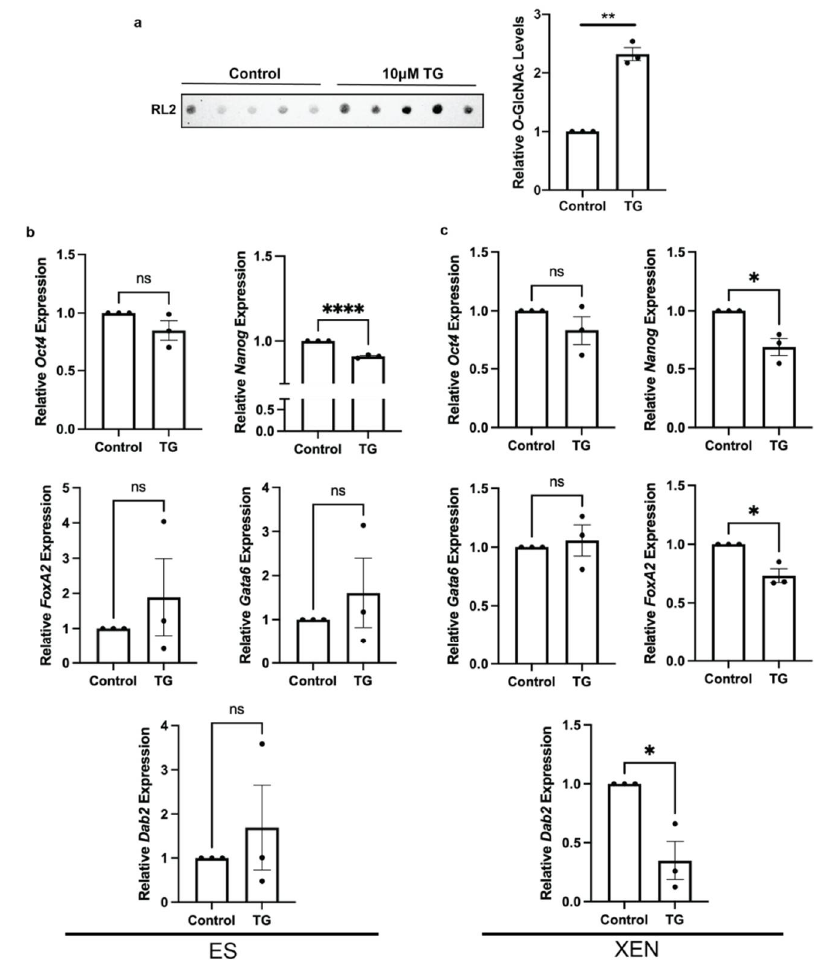
Figure 2. OGA inhibition alters pluripotency marker expression in ES cells and XEN marker ex- pression in XEN cells. The cells were treated with 10 µ M TG for 24 h: ( a ) immunodot blot and densitometry of O -GlcNAcylated proteins detected by the RL2 antibody in XEN cells; ( b , c ) expression of pluripotency gene expression Oct4 and Nanog and XEN marker expression FoxA2, Gata6 , and Dab2 in ES cells (left panel) and XEN cells (right panel). Bars represent mean values ± SEM, N = 3. * p < 0.05, ** p < 0.01, **** p <